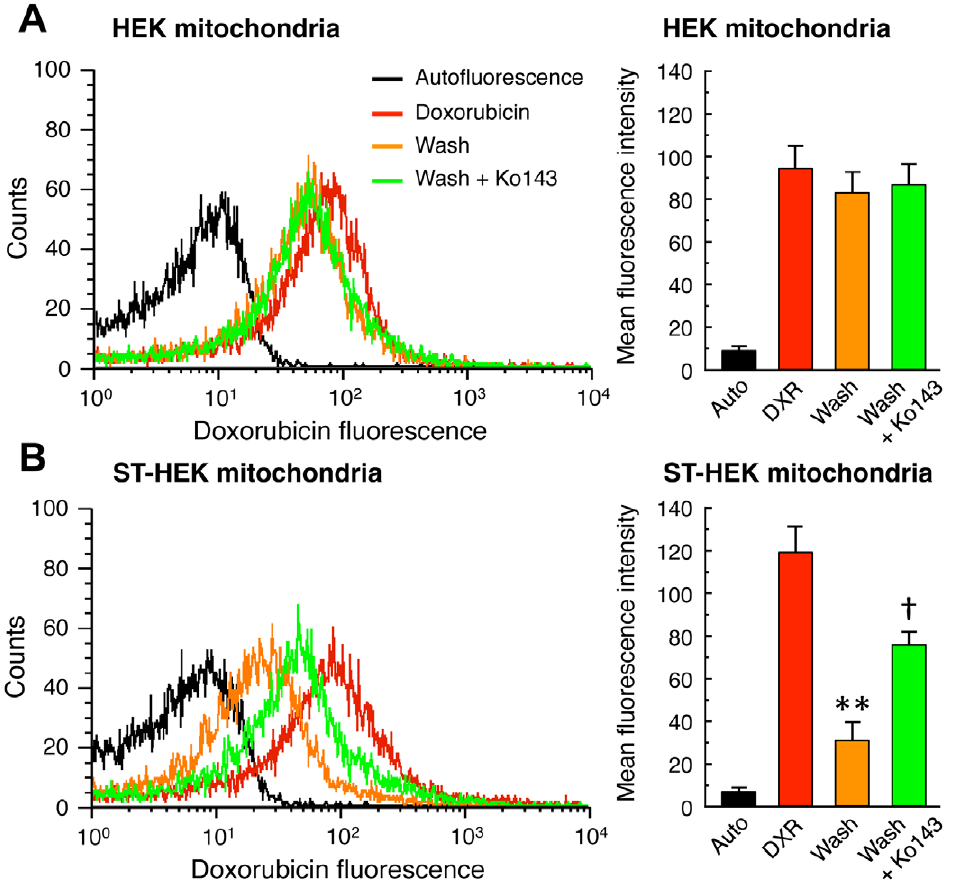
Figure 8. Accumulation and efflux of doxorubicin in mitochondria isolated from HEK cells and ST-HEK cells. Mitochondrial fractions were isolated as described in Materials and Methods. Mitochondrial preparations of HEK cells (A) and ST-HEK cells (B) were incubated with 5 m M doxorubicin for 10 min, then mitochondria were washed with doxorubicin-free buffer A with or without 1 m M Ko143 and incubated for 1 h. Left panel , contents of doxorubicin in mitochondria were analyzed using a flow cytometer. A representative histogram of three independent experiments is shown. Right panel , bar graphs show the flow cytometric analysis of the mitochondrial doxorubicin contents. Results represent the mean 6 SD of three independent experiments. Black bar indicates autofluorescence (Auto); red bar, doxorubicin treatment (DXR); yellow bar, wash without Ko143 (Wash); green bar, wash with Ko143 (Wash + Ko143). ** P , 0.01 vs. DXR. { P , 0.01 vs. Wash.